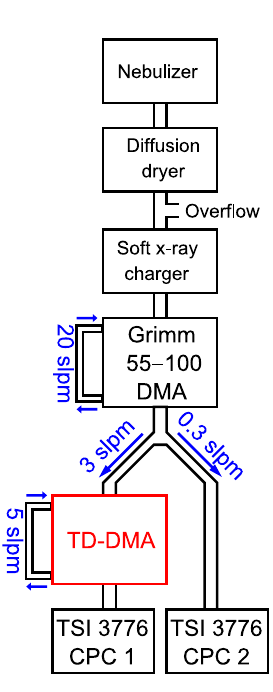
Figure 3. Tandem DMA setup for the characterization of the TD- DMA’s DMA